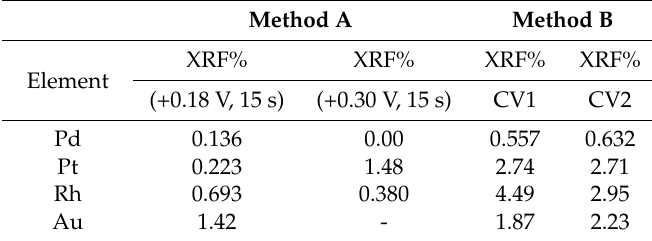
Table 2. XRF percentage of element deposited on SPC TTF Es by method A and B.